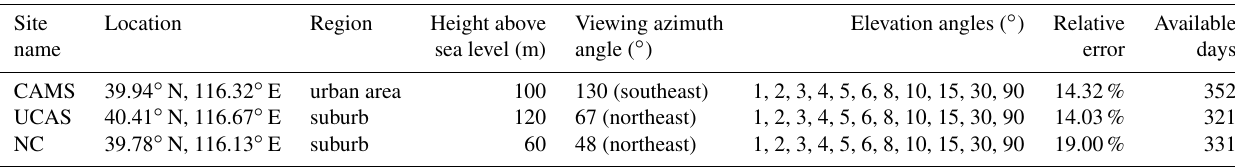
Table 2. Information on the MAX-DOAS measurements. The viewing azimuth angle of the north is taken as 0 ◦ . Relative error is calculated by mean of relative errors of MAX-DOAS measurements within ± 1h around the TROPOMI overpass